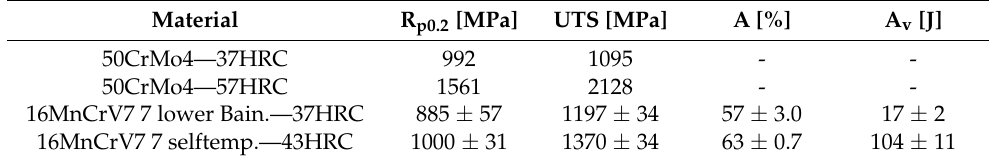
Table 2. Mechanical properties of the steel grades used in the present study.